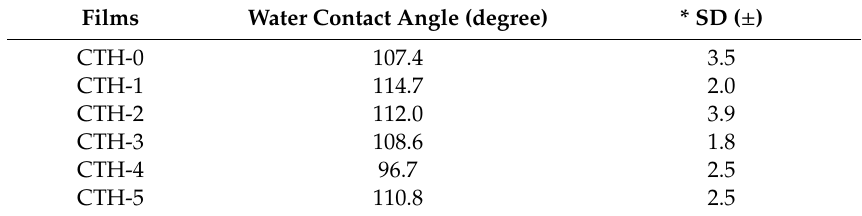
Table 3. Swelling data of CS/PAH films in deionized water.